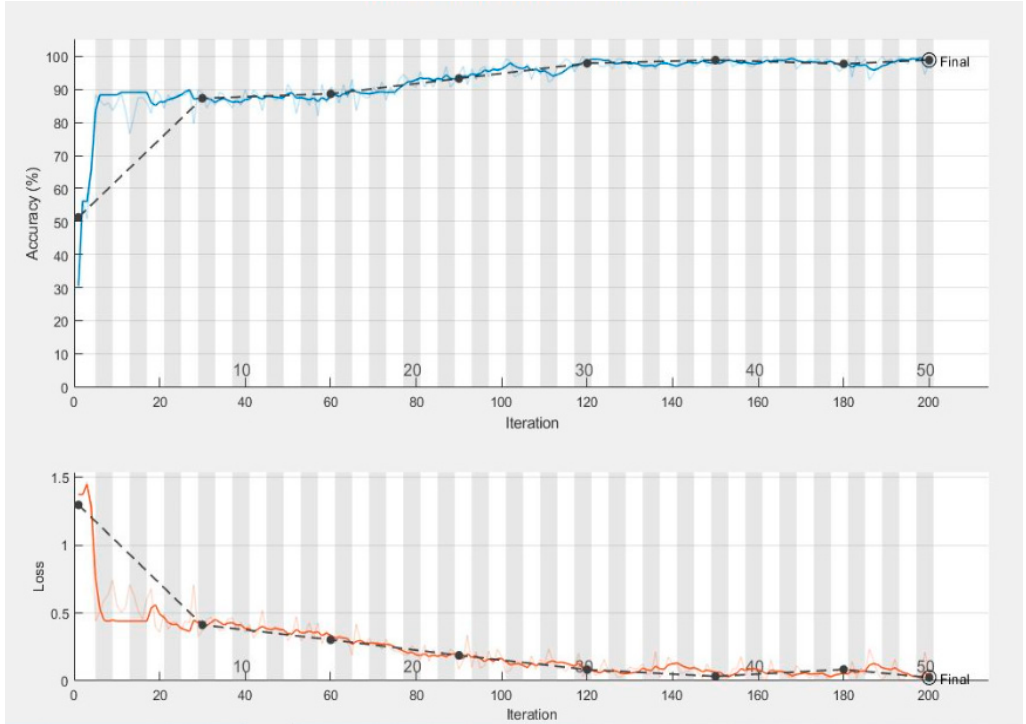
Figure 10. Graphical Representation of complete training process.